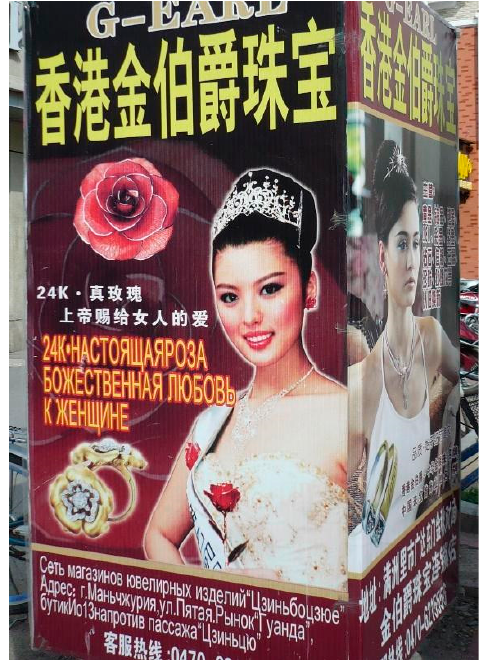
Figure 3. Advertisement for a jewelry store. Manzhouli.